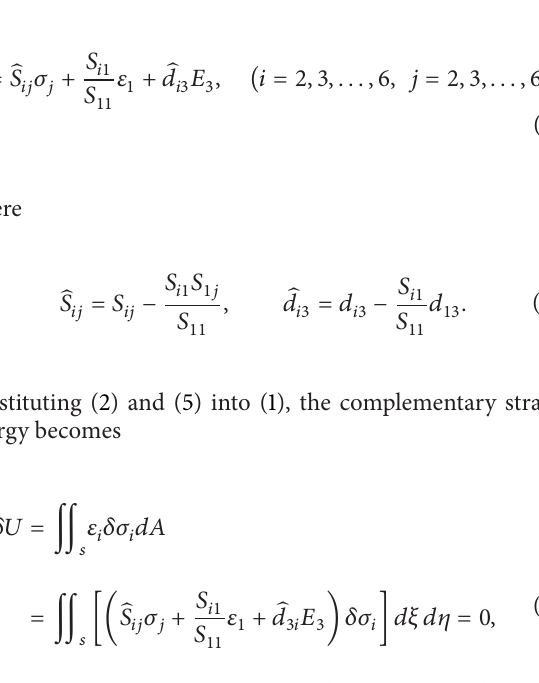
either Galerkin’s method or the principle of virtual work.